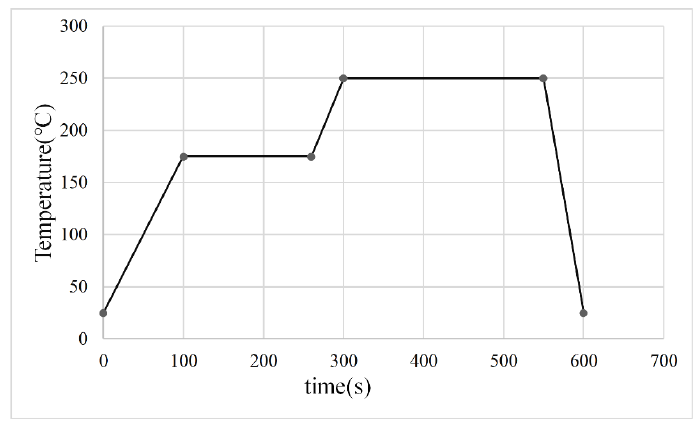
Figure 10. The welding temperature profile of sample preparation.